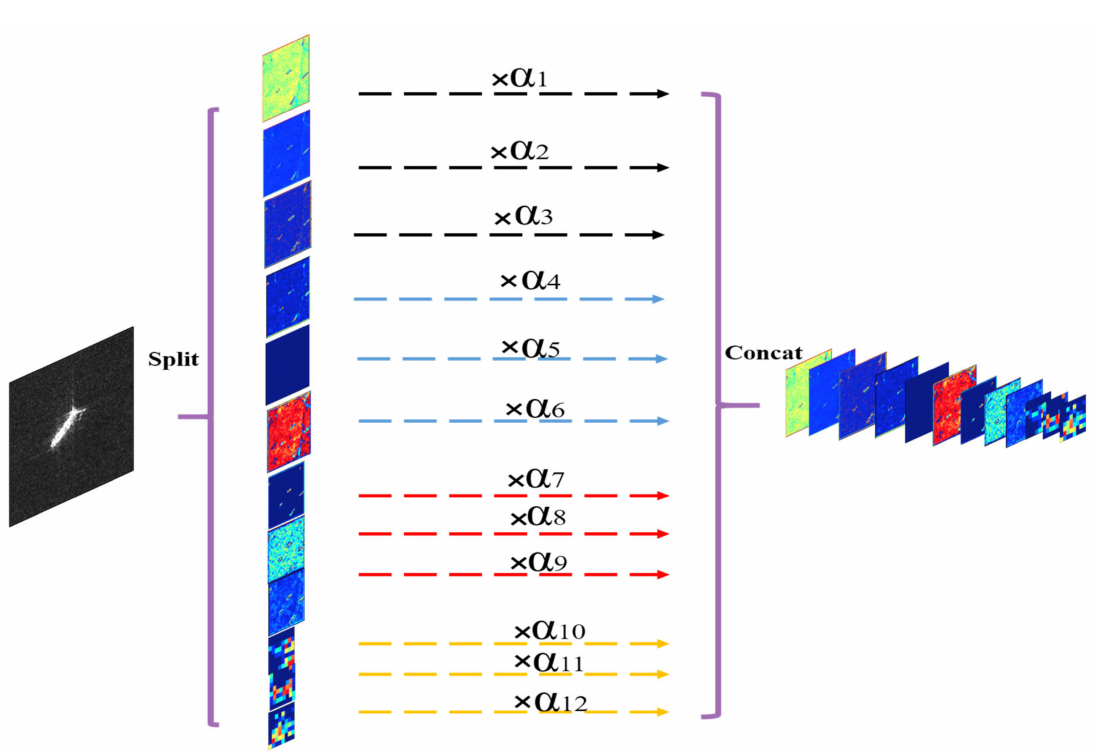
Figure 10. The diagram of MSAM, where α represents the weights applied to different feature